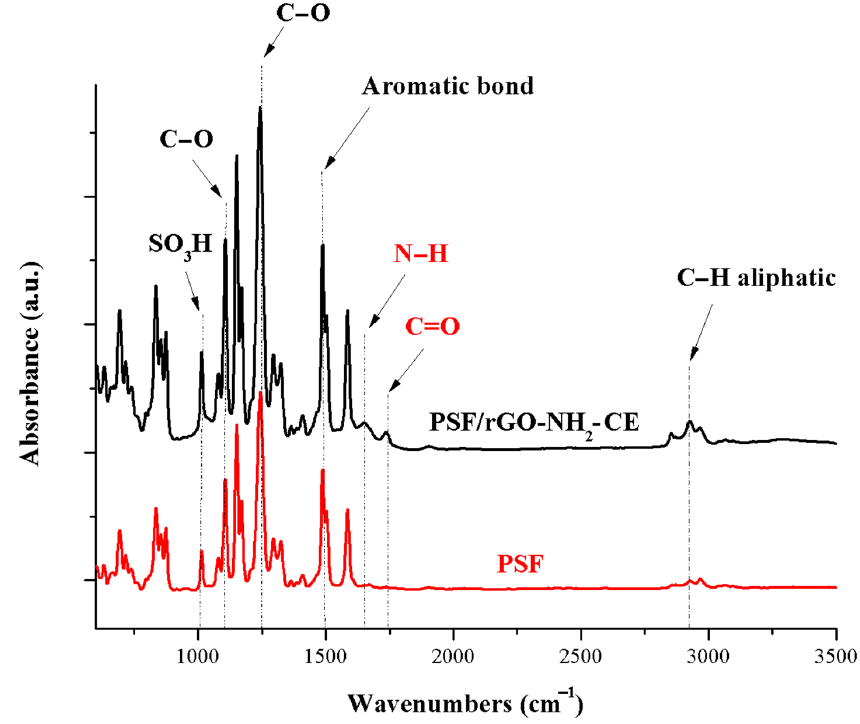
Figure 6. FT-IR spectra of PSF and PSF/rGO-NH 2 -CE.